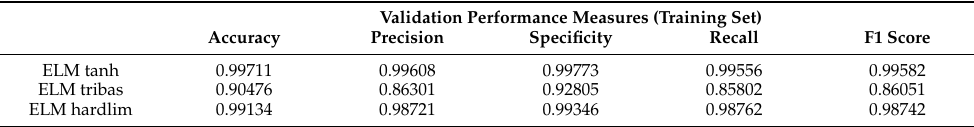
Table 15. Validation (training) classification performance measures of the ELM classifier for three different transfer functions of the ELM algorithm in dataset